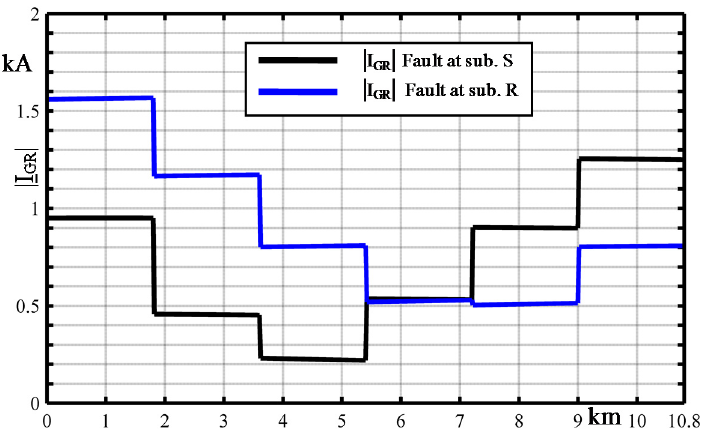
Figure 12. Faulted double-circuit UGC: ground return current magnitudes along the line (CB with PTs) for two different locations.